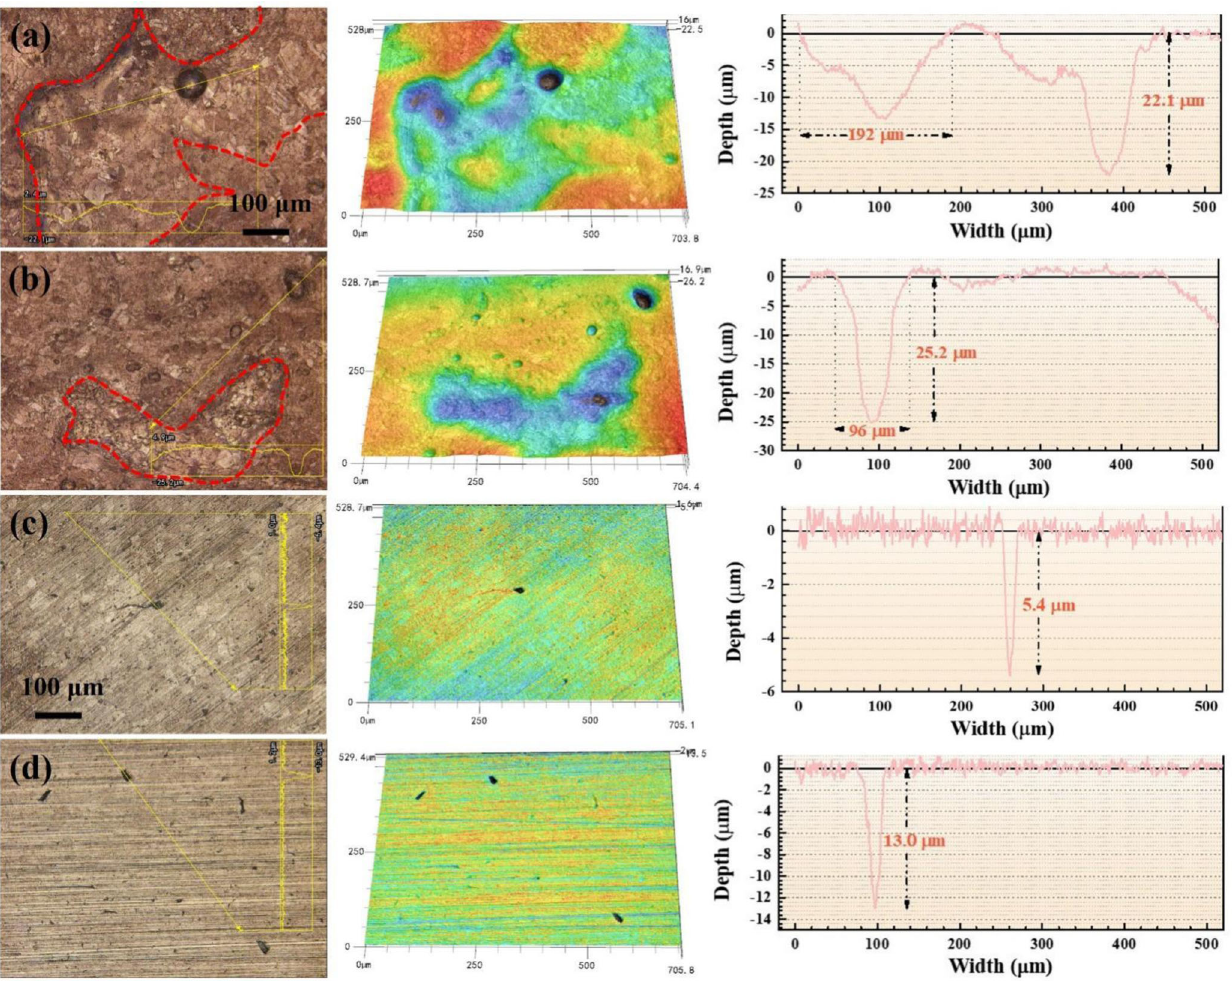
Fig. 7 CLSM. The typical pitting 3D morphologies and depth of the Cu and Ni coupons after the 7-d incubation in the D. vulgari s media: a Cu + D. vulgaris only; b Cu + D. vulgari s + ribo fl avin; c Ni + D. vulgaris only; d Ni + D. vulgari s + ribo fl